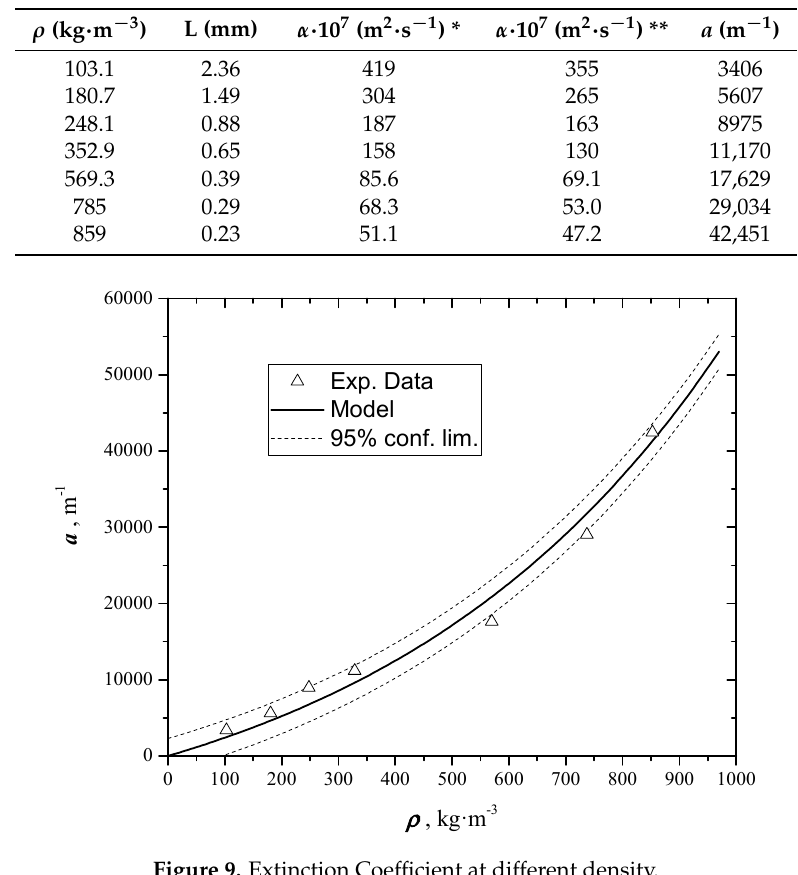
Figure 9. Extinction Coefficient at different